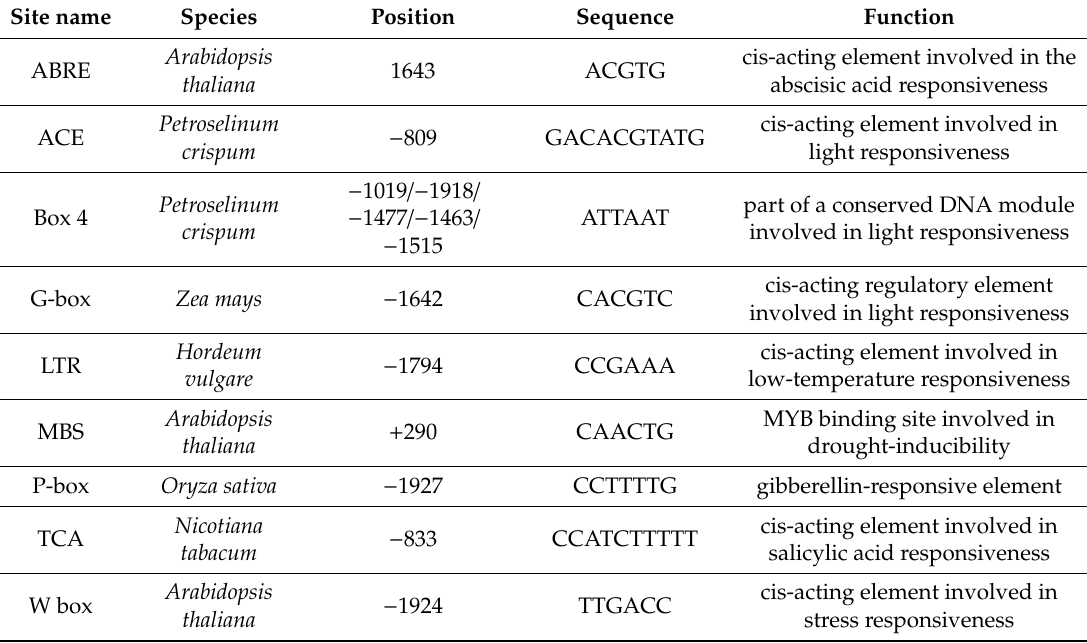
Table 2. The cis-acting elements identified in GmIREG3 promoter.